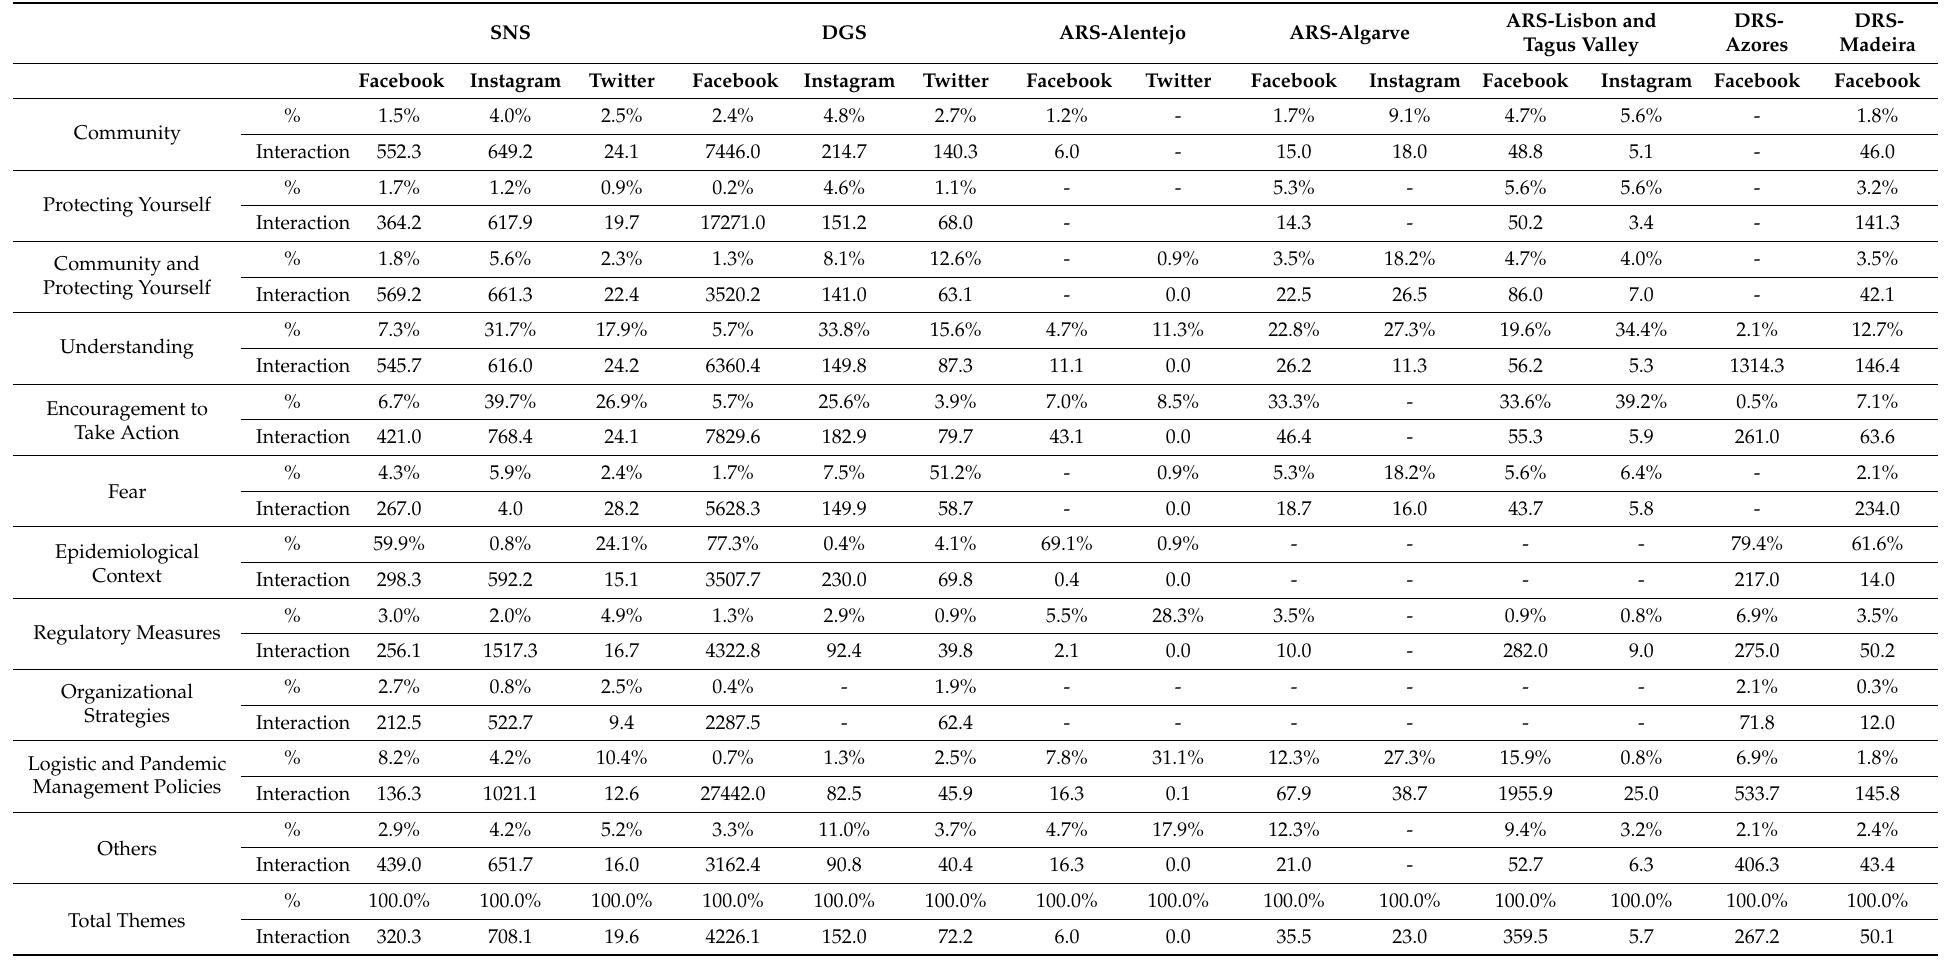
ARS-Lisbon and DRS- DRS- Tagus Valley Azores Madeira